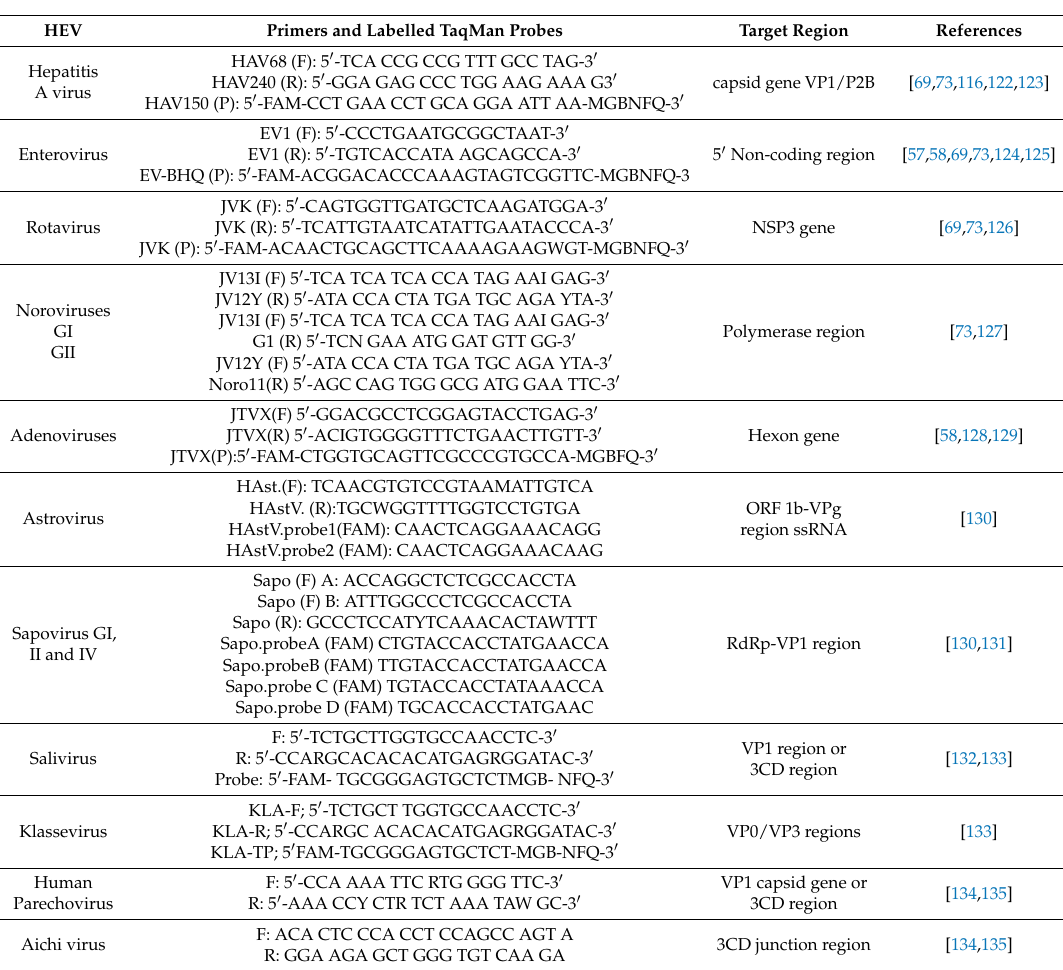
Table 3. Review and summary of published primers for PCR